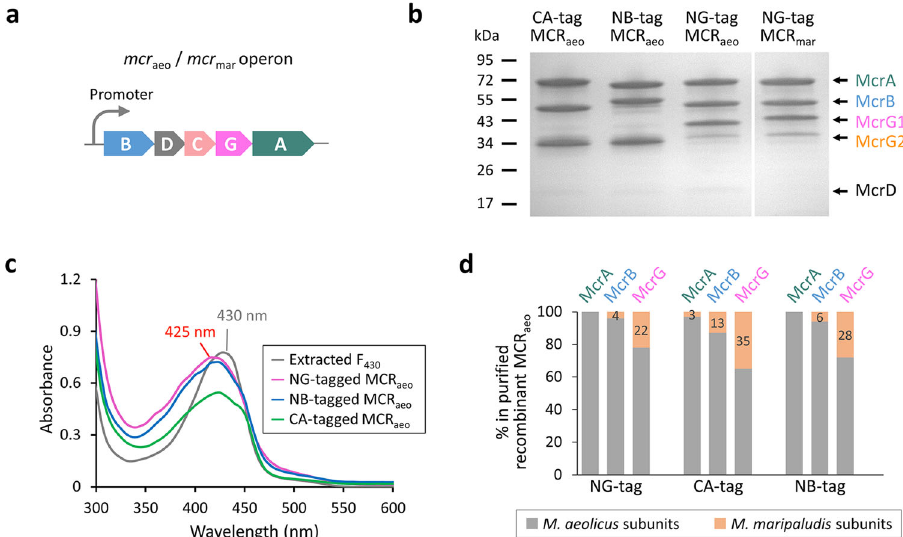
Fig. 2 Heterologous expression of methanococcal MCRs. a The mcr operon structure of M. aeolicus ( mcr aeo ) and M. maripaludis ( mcr mar ). b SDS-PAGE analysis of the recombinant MCR aeo and MCR mar puri fi ed by Strep-tag af fi nity and ion-exchange chromatography from M. maripaludis . The molecular weights based on standards are labeled on the left. The Flag-Strep 2 tag was added to the C-terminus of McrA (CA), the N-terminus of McrB (NB), or the N-terminus of McrG (NG) positions. All subunits were identi fi ed by MALDI-TOF MS and labeled on the right. McrG1 and McrG2 represents tagged and untagged McrG, respectively. c UV – visible spectra of puri fi ed recombinant MCR aeo and MCR mar (all at 7.5 mg mL − 1 concentration) compared to coenzyme F 430 extracted from the M. marburgensis MCR. d The relative abundance of M. aeolicus (in gray) vs. host M. maripaludis (in orange) MCR in each subunit of the puri fi ed recombinant MCR aeo complex determined by LC-MS/MS. The percentages of M. maripaludis protein in total protein of each subunit are